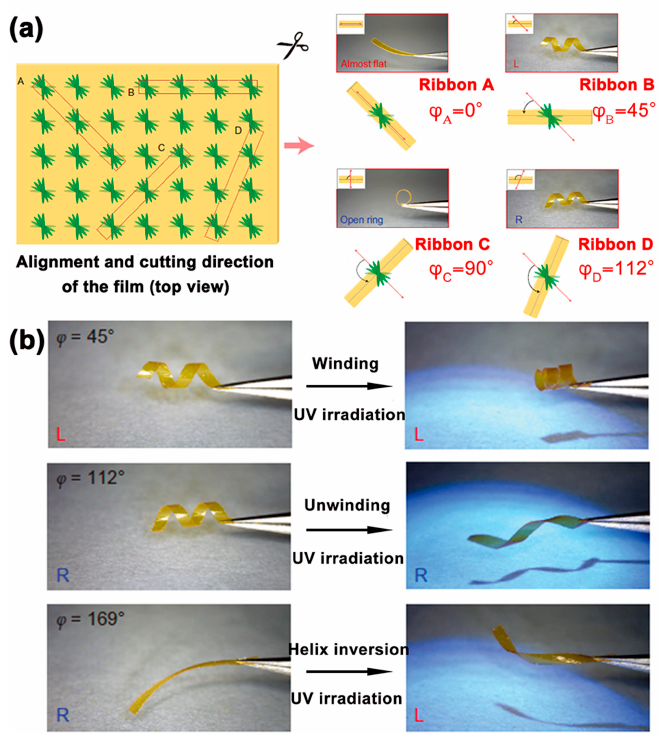
Figure 4 . ( a ) Ribbons show distinct macroscopic shapes depending on the direction they are cut, ribbon A is almost flat, ribbon C exhibits an open-ring shape, ribbon B and D displayed left-handed or right-handed shape, respectively. ( b ) The mechanical motions (i.e., winding, unwinding, and helix inversion) can be observed by the naked eye via different ribbons triggered by UV light irradiation.